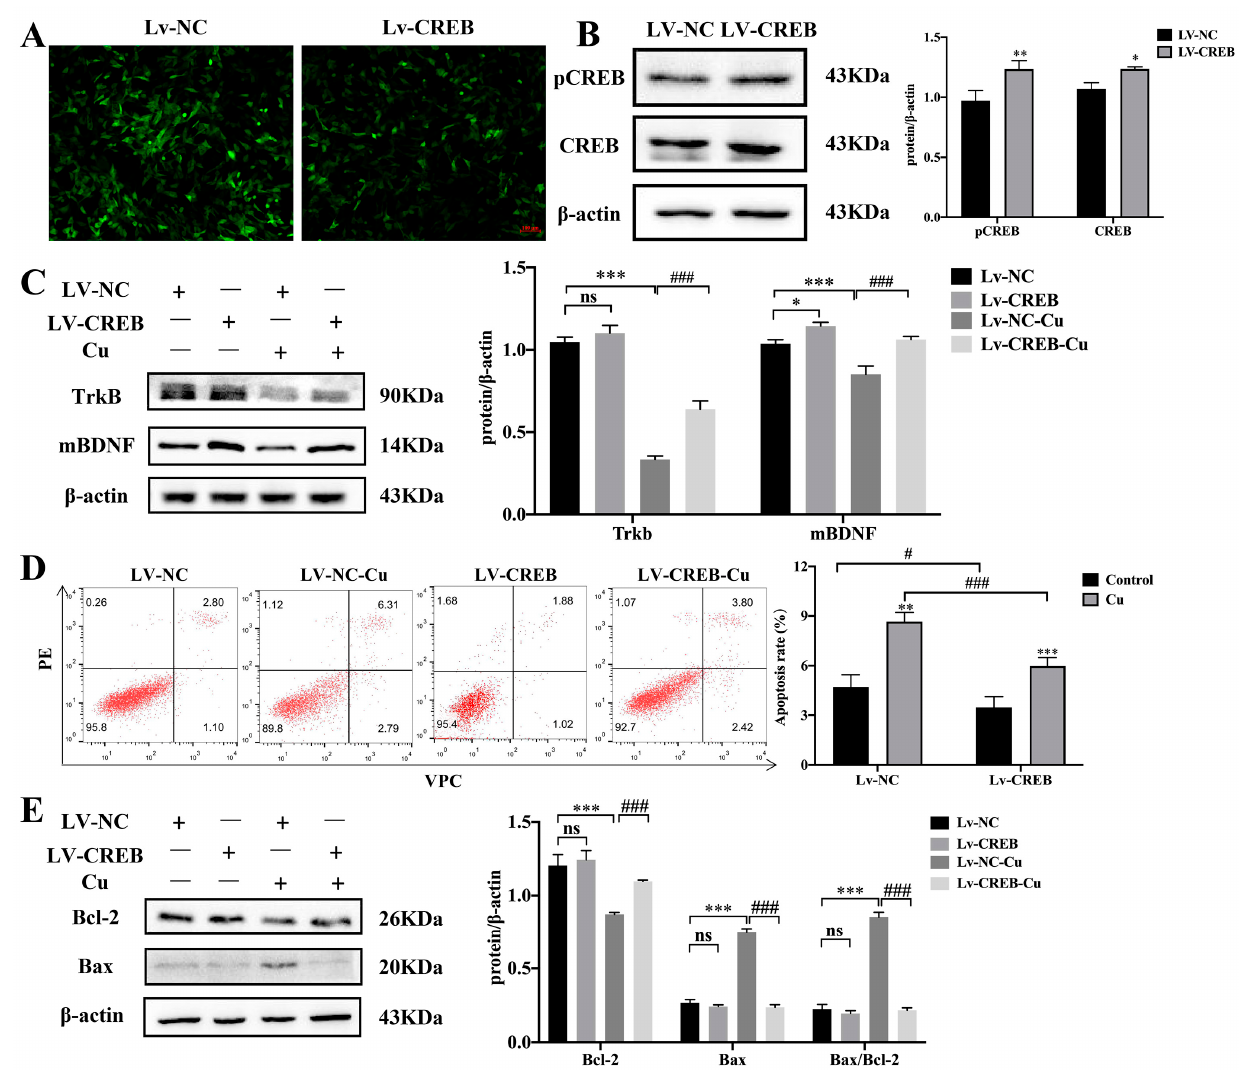
Figure 5. Effects of Cu on the CREB-upregulated HT22 cells. ( A ) HT22 cells transfected with lentivirus were pictured by fluorescence microscope (scale bar = 200 µm). ( B ) The protein expression and quantitative analysis of pCREB and CREB after LV-CREB transfection. ( C ) The protein expression and quantification of TrkB and mBDNF after LV-CREB and Cu treatment. ( D ) Flow cytometry results and apoptotic index of HT22 cells after LV-CREB and Cu treatment. ( E ) The protein expression and quantification of Bax and Bcl-2 after LV-CREB and Cu treatment. * p < 0.05, ** p < 0.01, *** p < 0.001, compared with LV-NC; # p < 0.05, ### p < 0.001, compared with LV-NC-Cu; ns means no significant difference.